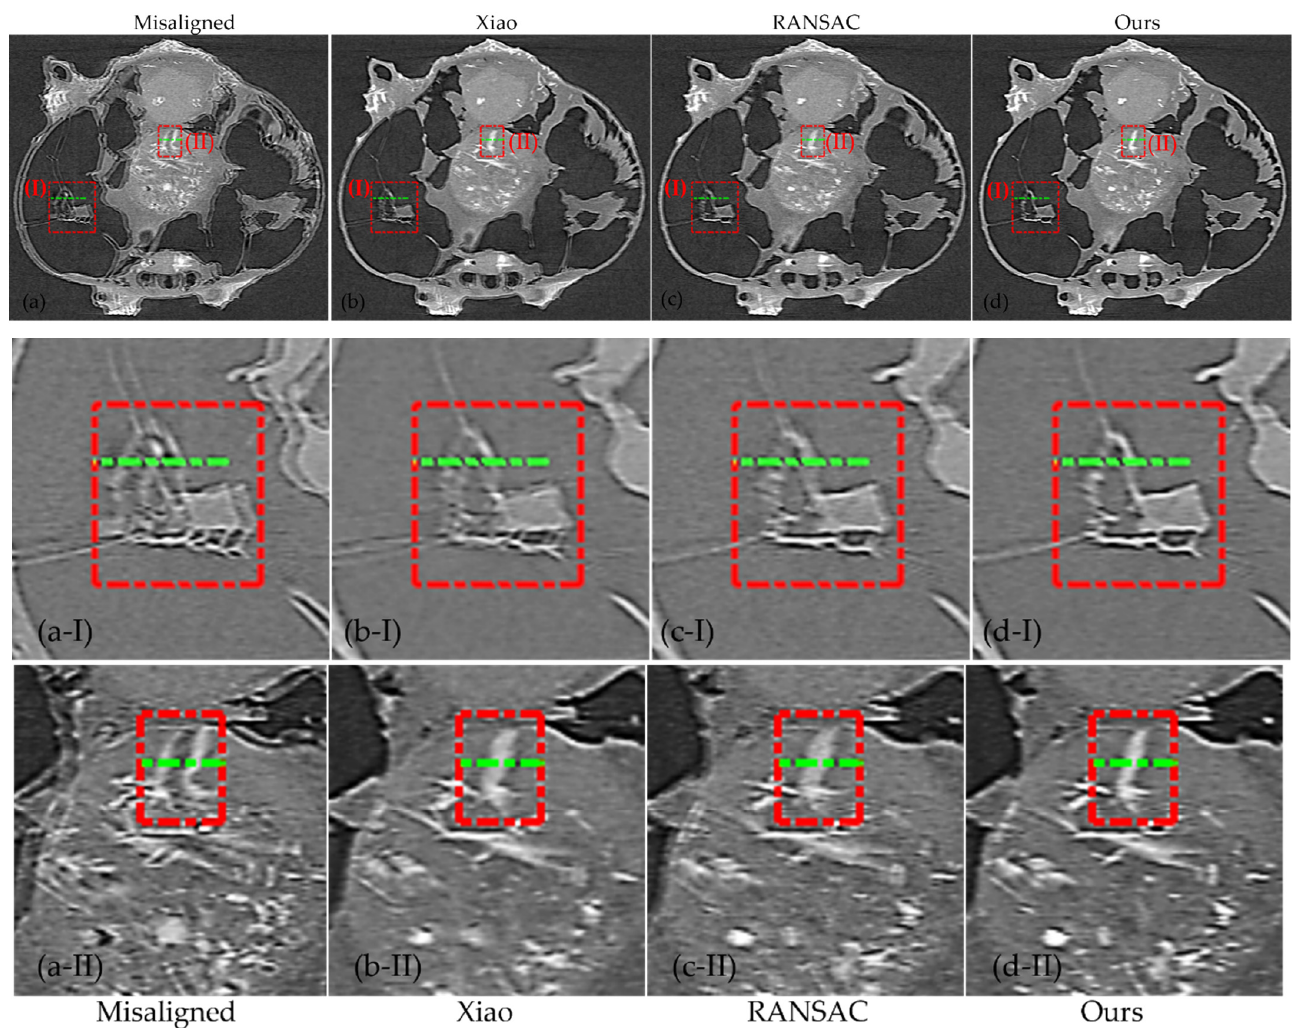
Figure 10. The Ants data reconstruction results with different parameters. ( a ) Misaligned parameters. ( b ) Parameters calculated using Xiao et al.’s method, ( c ) RANSAC feature-point screening results. ( d ) Parameters calculated using our proposed method. ( a - I )–( d - I ) is an enlarged view of the I position of a–d. ( a - II )–( d - II ) is an enlarged view of the II position of a–d.